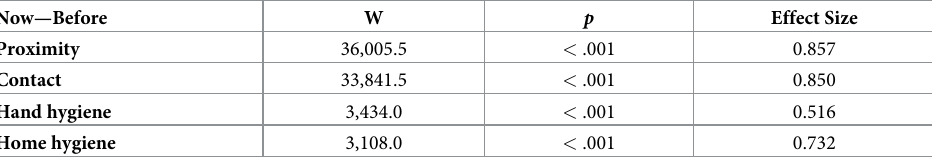
Table 1. Results of signed-rank tests comparing behavior before and during the pandemic.